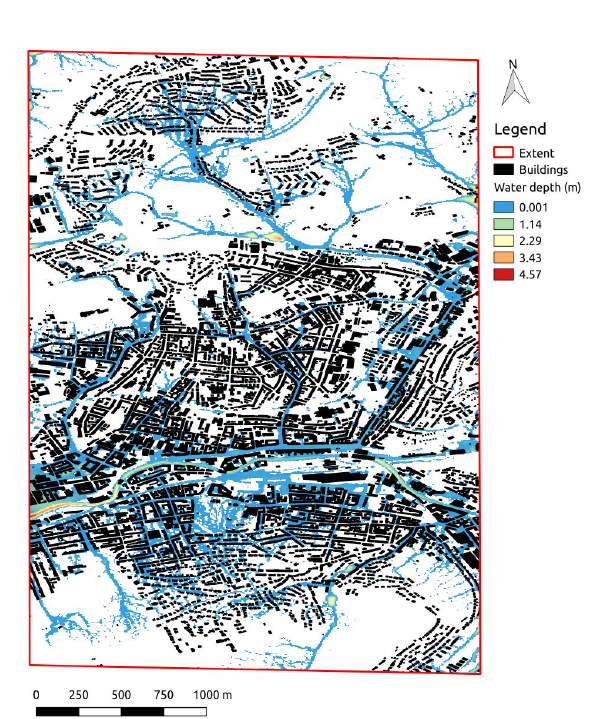
Figure 6. Water depth estimated by CAMC at the end of the